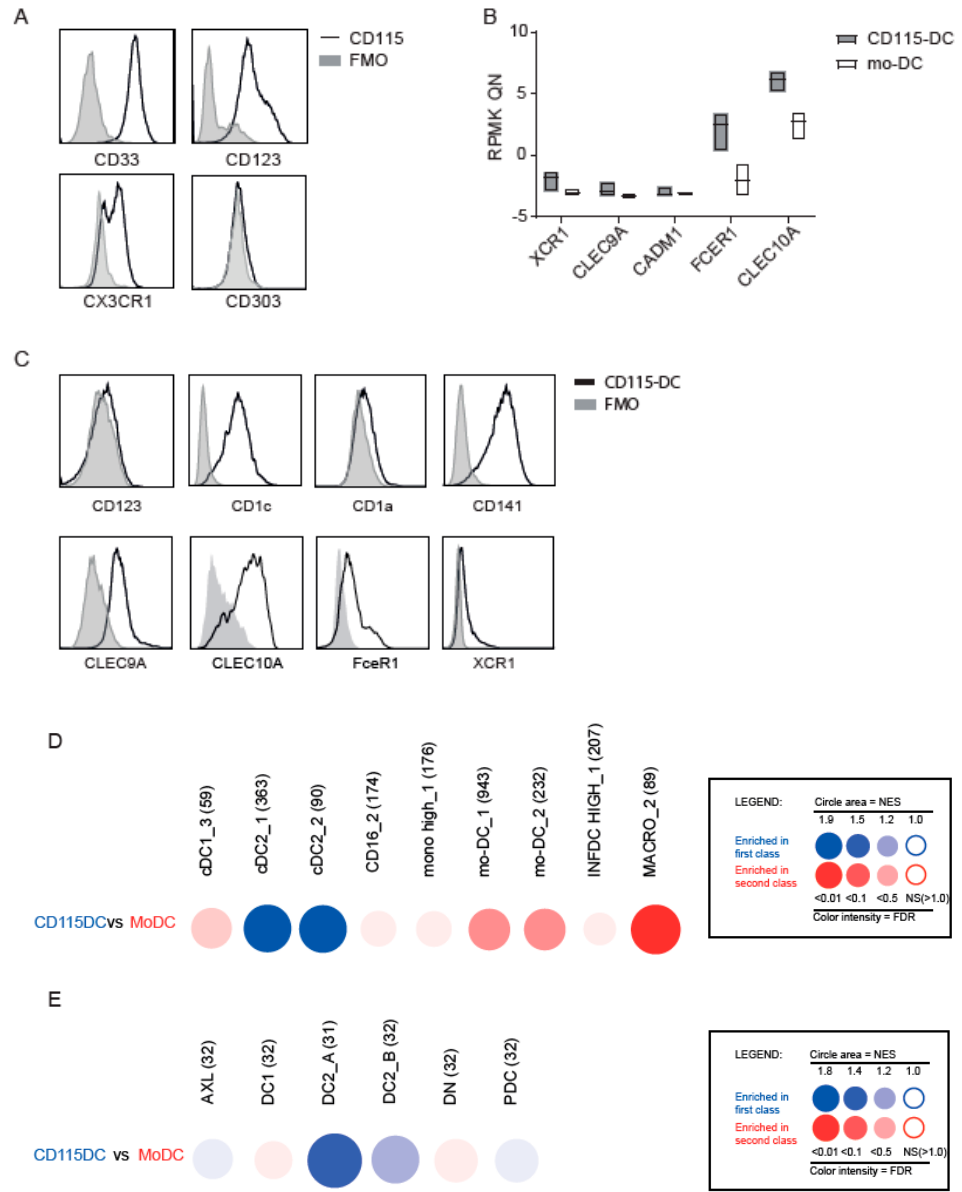
Figure 6. Identification of specific CD115 profile. Transcriptome analysis of CD115(-DC) and mo(-DC) was performed by RNA sequencing of sorted precursors or differentiated DCs generated from CB-derived CD34 + stem cells from three to five donors. For FACS analysis, alive cells were gated with SSC/FSC, followed by doublet exclusion based on FSC-W/FSC-A. ( A ) Protein levels of markers expressed on myeloid precursors studied on CD115 progenitors with a fluorescence minus one (FMO) as negative staining control. ( B ) Normalized RNA levels of genes expressed by different DC subsets. ( C ) Protein expression of CD123, CD1a, CD1c, CD141, CLEC9A, CLEC10A, FceR1, and XCR1 within CD115-DCs with FMO control. ( D , E ) CD115-DCs and mo-DCs were compared for their relative enrichment in publicly available gene sets using Gene set enrichment analysis (GSEA) through the BubbleGUM software. Results are represented as bubbles in a color matching that of the cell subset in which the gene set was enriched. Stronger and more significant enrichments are represented by bigger and darker bubbles, as illustrated in the legend box of the figure. Specifically, the surface area of the bubbles is proportional to the absolute value of the normalized enrichment score (NES). The color intensity of the dots is indicative of the false discovery rate (FDR) statistical value. The gene sets were defined based on those used by Bakdash et al. [22], Balan et al. [12], Segura et al. [23] ( D ), and Villani et al. [15] ( E